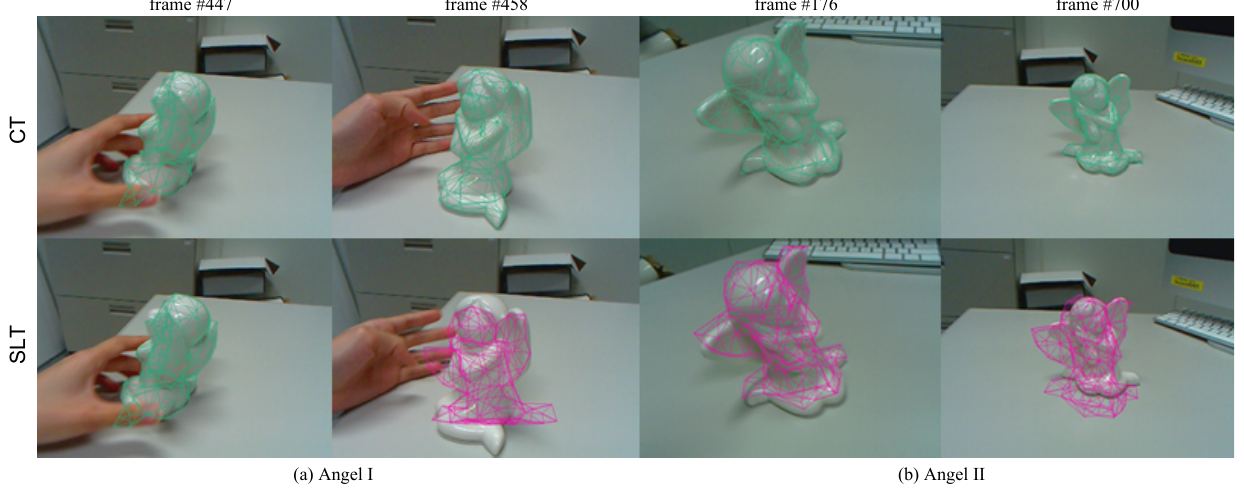
Fig. 17. Qualitative evaluation for the angel. Two conditions are considered: (a) the user moving the object (two images on the left) and (b) the camera moving around the object (two images on the right). In the upper sequence, CT does not present any failure. In the bottom sequence, SLT fails in some poses.